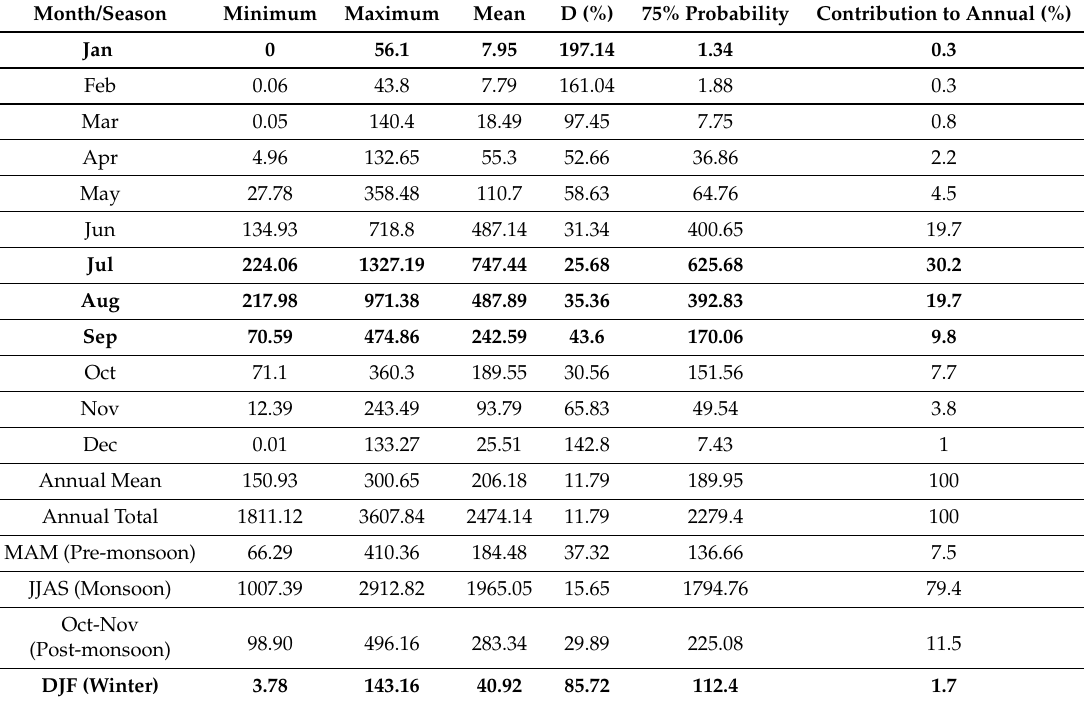
Table 1. Descriptive statistics of rainfall series. 75% probability in the table means, chances of having rainfall with more than given value. The unit of the rainfall for minimum, maximum, mean, and 75% probability is mm. Bold style represents 90% level of significance in trend results.